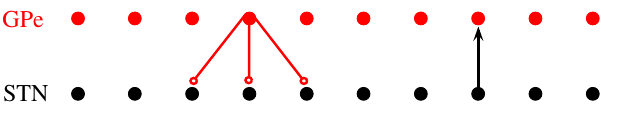
Figure 1. Coupling pattern of the STN-GPe neuronal network. Black circles depict STN cells, red circles depict GPe neurons. Each STN neuron excites a single GPe cell, whereas each GPe cell inhibits three STN